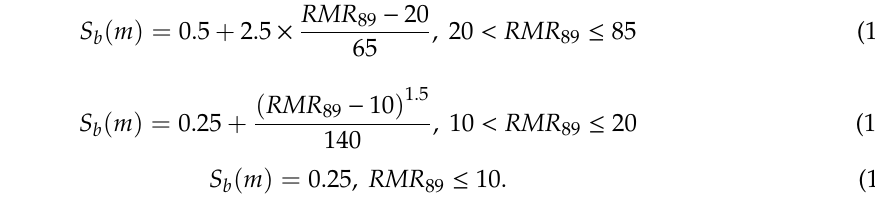
Table 1. Characterization criteria in di ff erent versions of the rock-mass rating ( RMR )